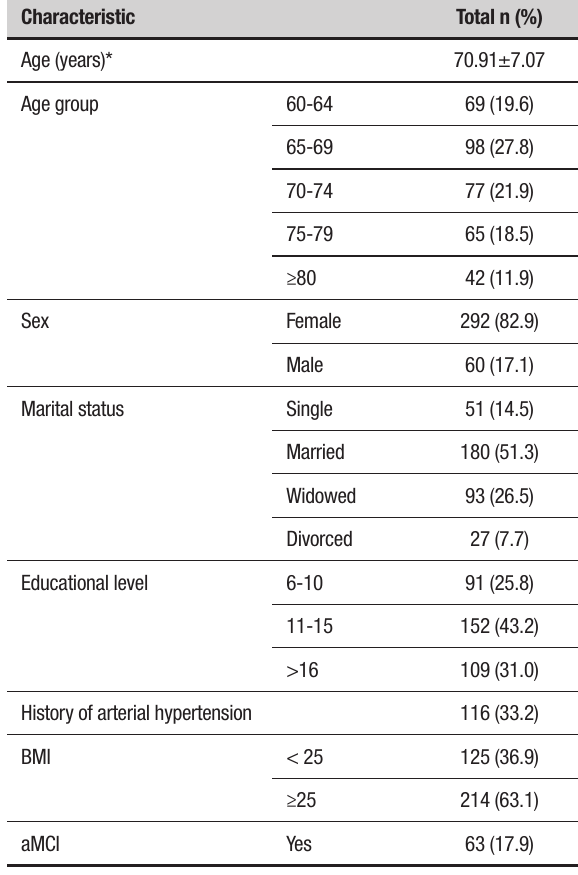
Table 1. Sociodemographic characteristics of participants (n=352).